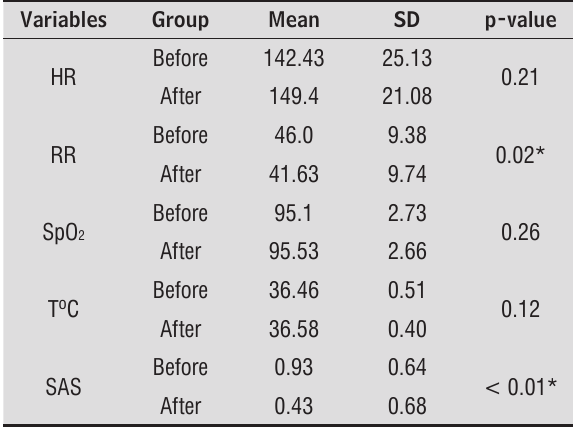
Table 5 - Comparison of the variables before and after